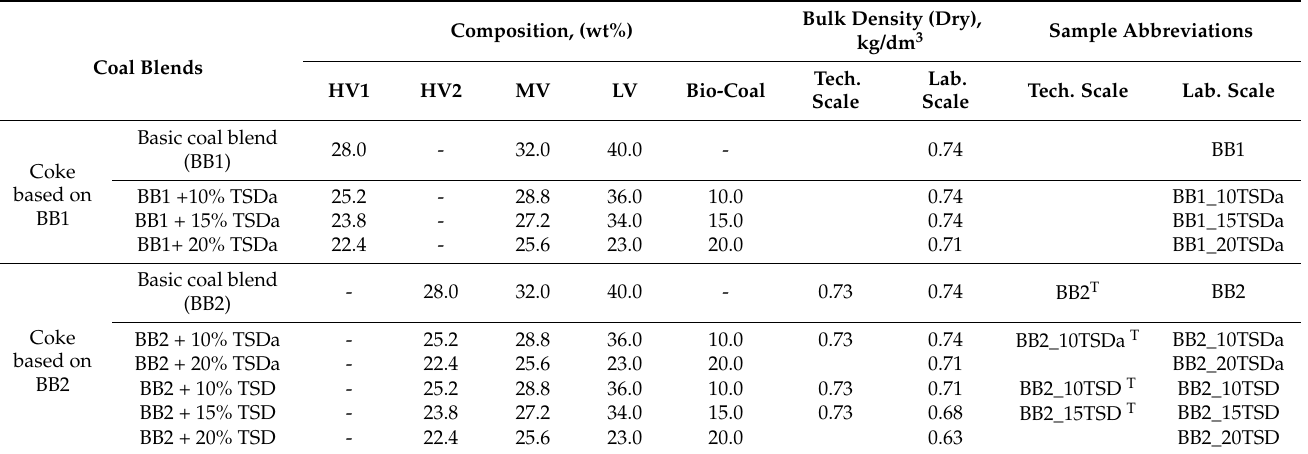
Table 2. Mixing ratios of coals and bio-coal (wt%) for coking coal blends used in laboratory and technical-scale carbonization, achieved bulk density of packed bed and abbreviations of the sam- ple